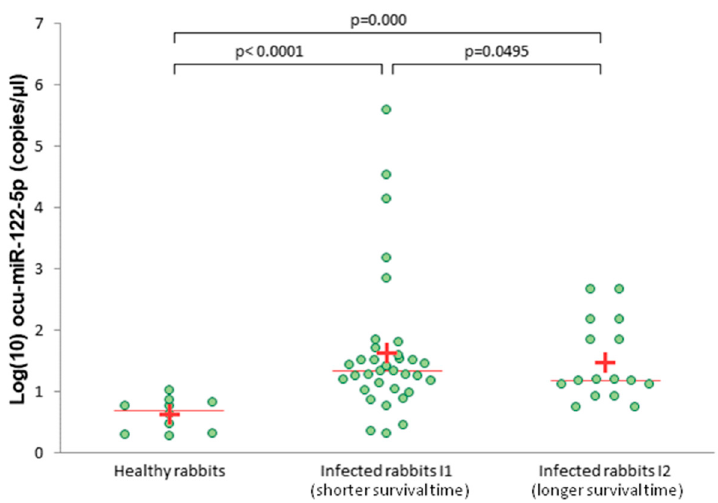
Figure 3. Absolute levels of serum ocu-miR-122-5p in healthy and infected rabbits (group I1 and I2), measured by ddPCR. A plus ( + ) indicates the average; a line indicates the median.